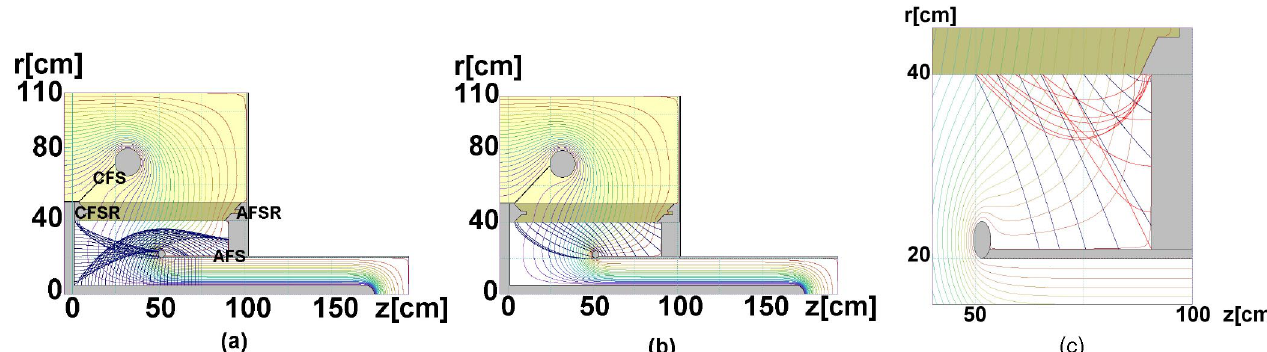
FIG. 12. (Color) Ray-tracing calculations at the front of a pulsed-power machine with a central stalk. The knob in the cathode field- shaping ring (CFSR) and the notch in the anode field-shaping ring (AFSR) are simple attempts to add mechanical strength but have a negligible EM effect. In (a) electrons (blue trajectories) originating on the cathode surfaces, in (b) secondaries emitted along the monolithic insulator, whereas in (c) positive ions (red trajectories) emitted at the enlarged anode end are traced. Contours of the voltage distribution are also drawn.